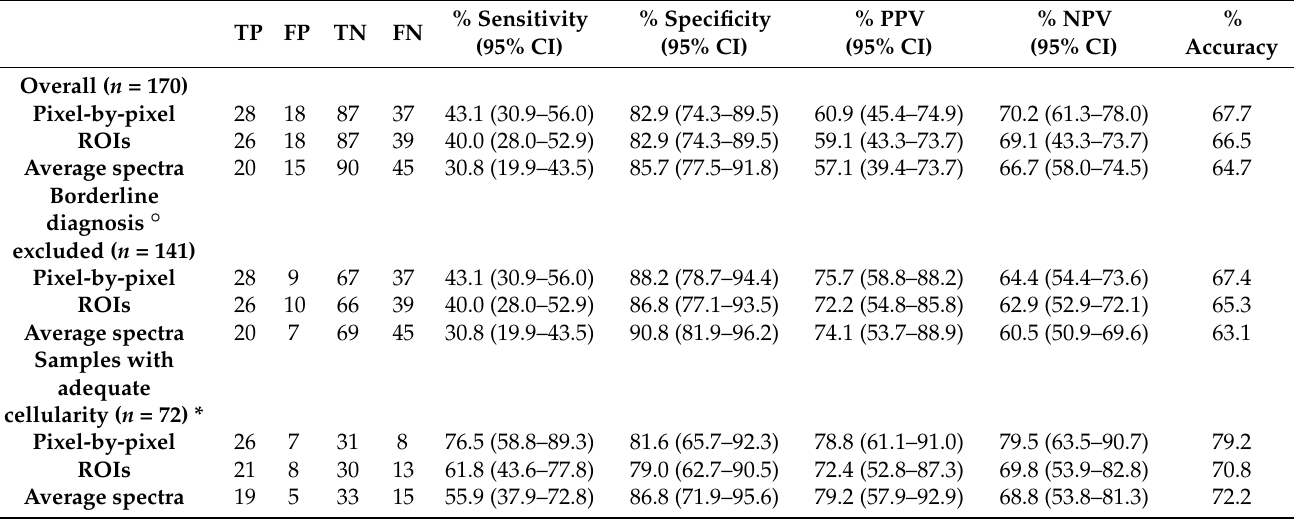
Table 1. Performances of the classifier on the three MALDI-MSI approaches in the validation set, overall and by